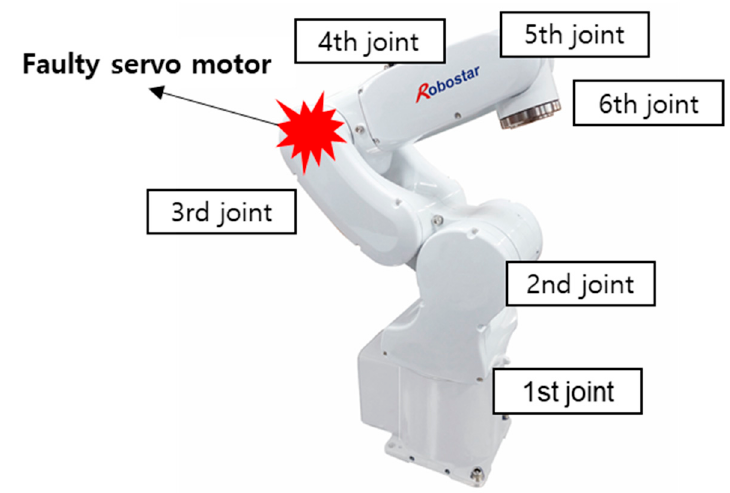
Figure 6. Description of the robot servo motor fault location in the robot.